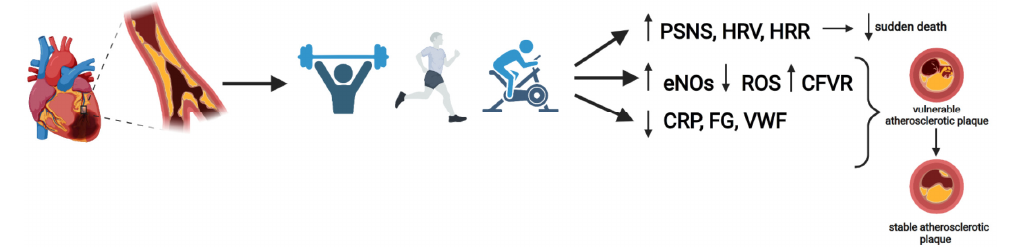
Figure 1. Beneficial effects of exercise training on the CAD risk factors including inflammation, sym- pathetic activity and endothelial dysfunction. Created with BioRender.com accessed on 1 March 2022. CAD: Coronary artery disease; PSNS: parasympathetic nervous system; HRV: heart rate variability;